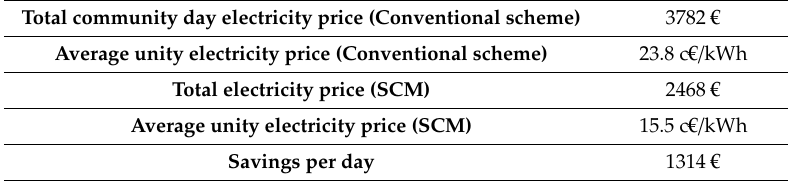
Table 6. Economic analysis of one-day OPF simulation (summer case).